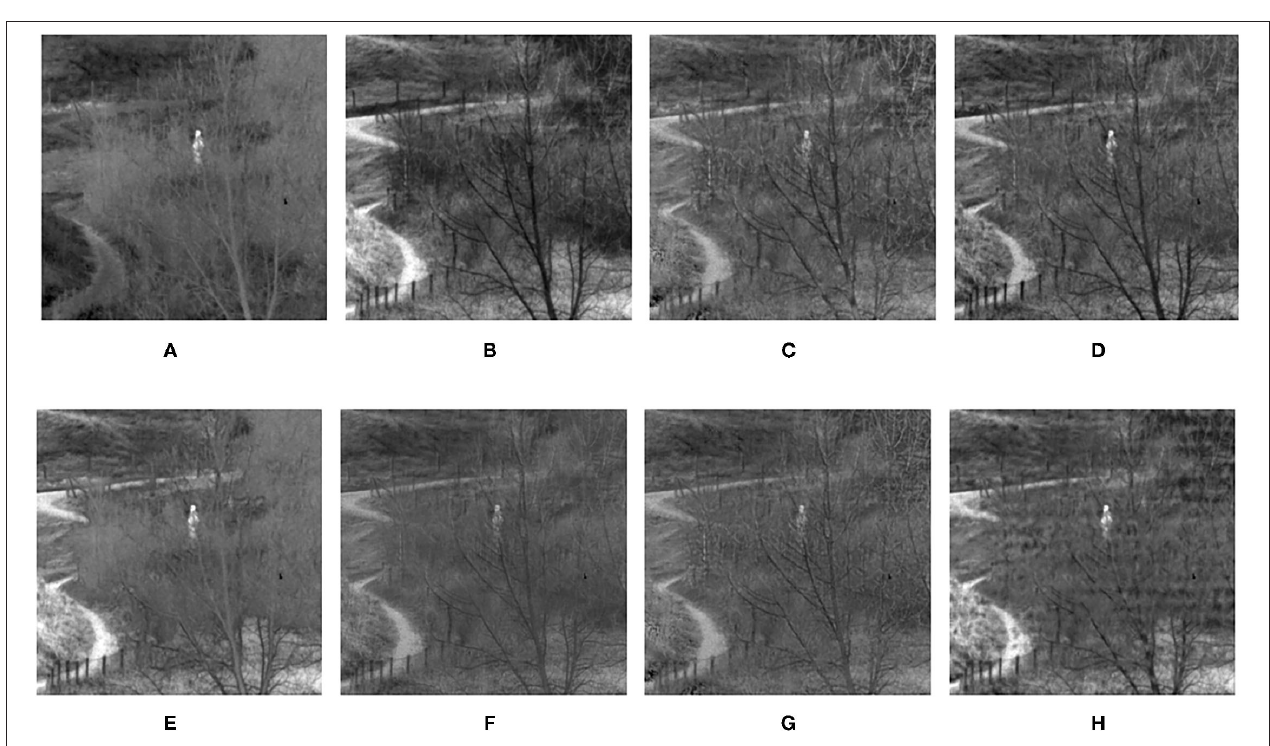
FIGURE 11 | Comparison experimental results of infrared and visible images. (A) original image (infrared image); (B) original image (visible image); (C) DWT; (D) LP; (E) SR; (F) DTCWT-SR; (G) VGG; (H) MPS.